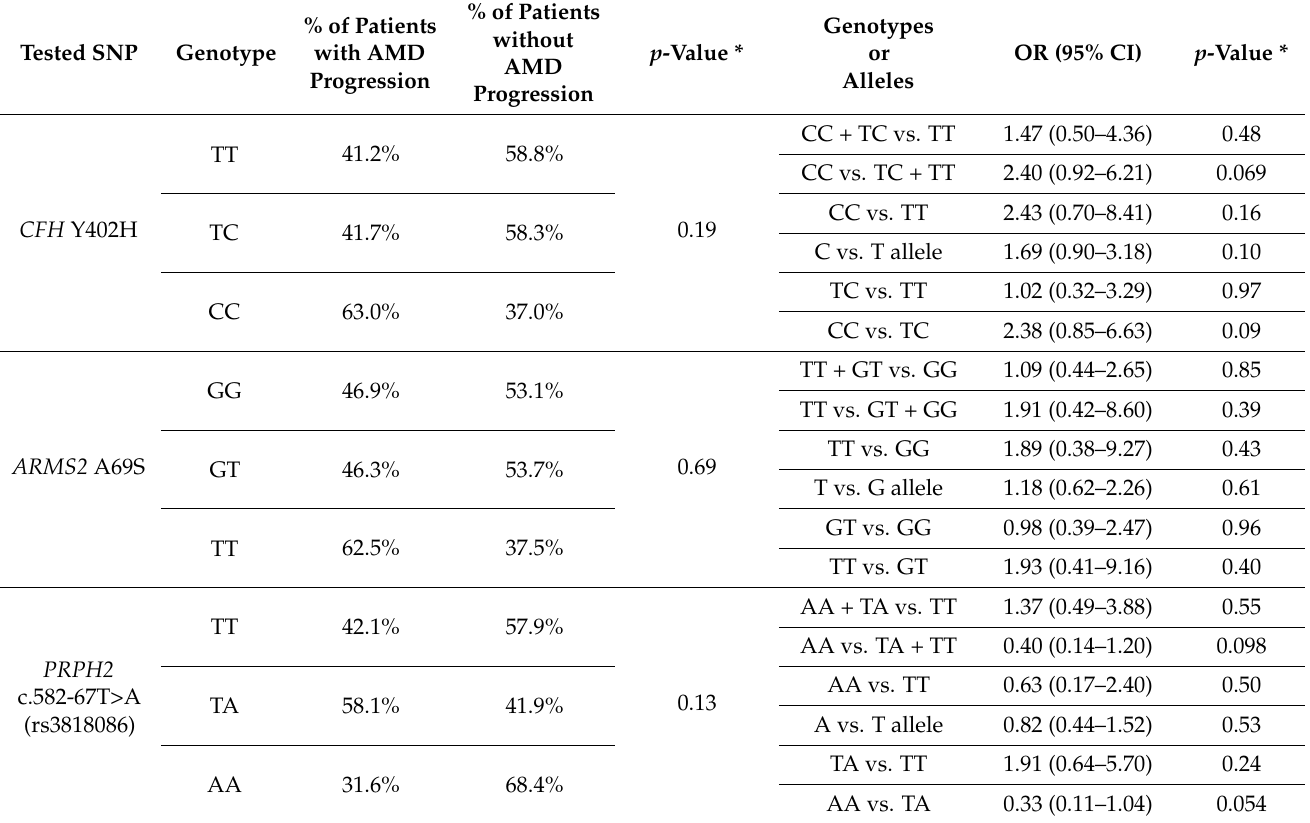
Table 4. State of disease progression with regard to the genetic background of patients.